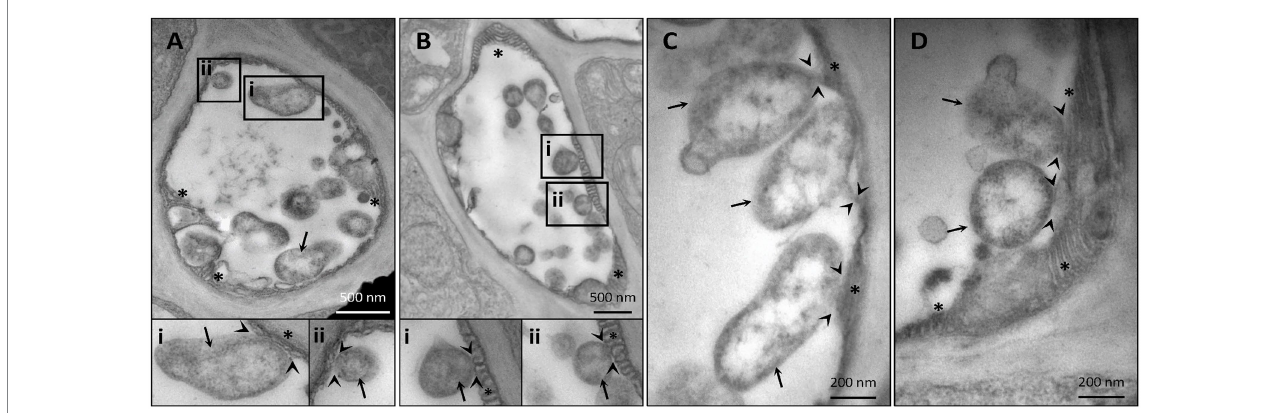
FIGURE 2 Representative TEM micrographs of infected sieve elements illustrate an adhesion of phytoplasmas to the sieve-element endoplasmic reticulum (SE-ER) (A–D) . The junction sites seldom show clear-cut outlines. In insets i and ii, areas of interest of (A) and (B) are magnified. Arrows = phytoplasmas; arrow- heads: phytoplasma-SE-ER contacts; asterisks: SE-ER; pp.: sieve-element protein.